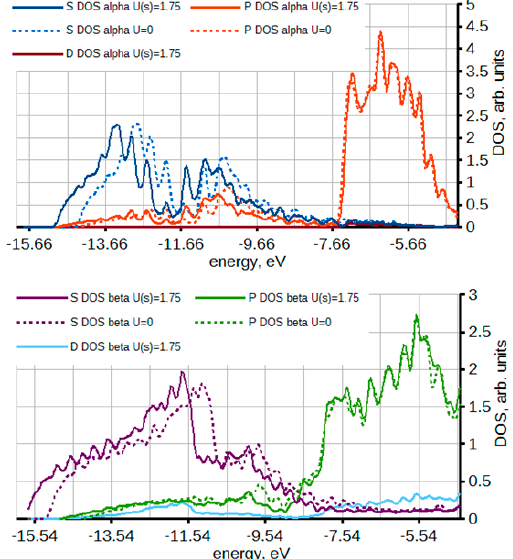
Figure 6. The density of states of alpha ( top ) and beta ( bottom ) Sn projected on s , p , and d orbitals also showing the results of Hubbard U correction (U(s) = 1.75 eV). The plot is up to the Fermi level. Reprinted from [28], used in accordance with the Creative Commons Attribution (CC BY) license (https://creativecommons.org/licenses/by/4.0/).